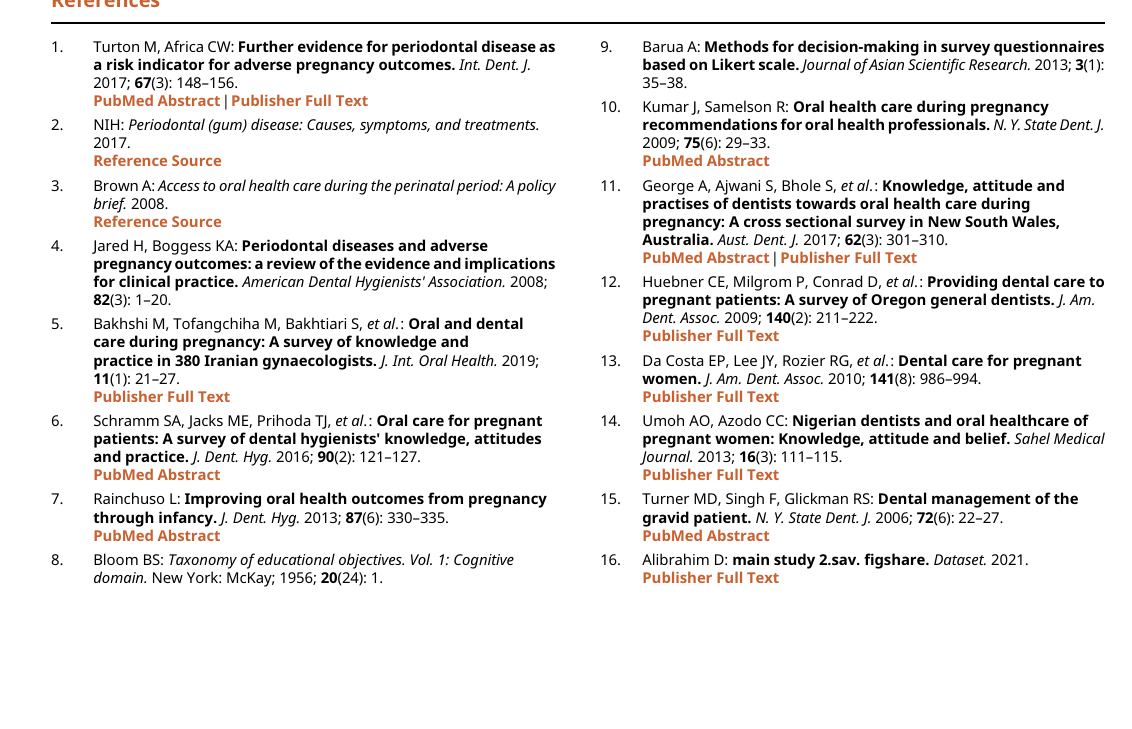
This project contains the following underlying data: